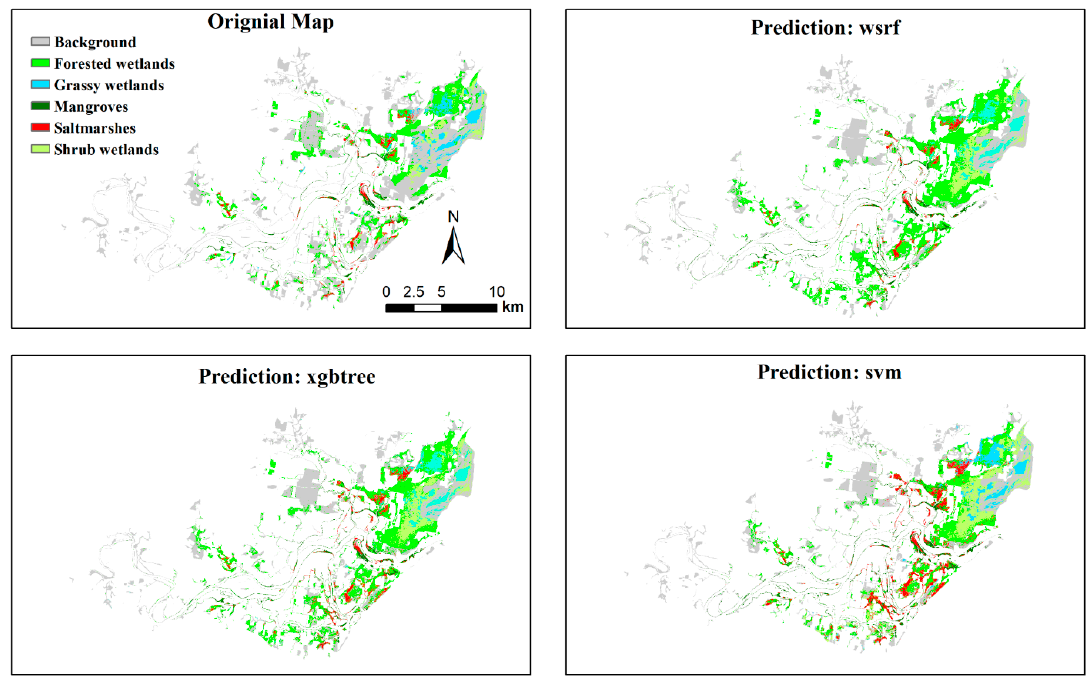
Figure 3. Comparison of mapped and predicted wetland distribution in Manning River Estuary. The original wetland map was an aggregation of the wetland map by Reference [55] Over-estimation of shrub wetlands and saltmarshes in the Crowdy Bay National Park at the upper right of the estuary is evident for all ensemble